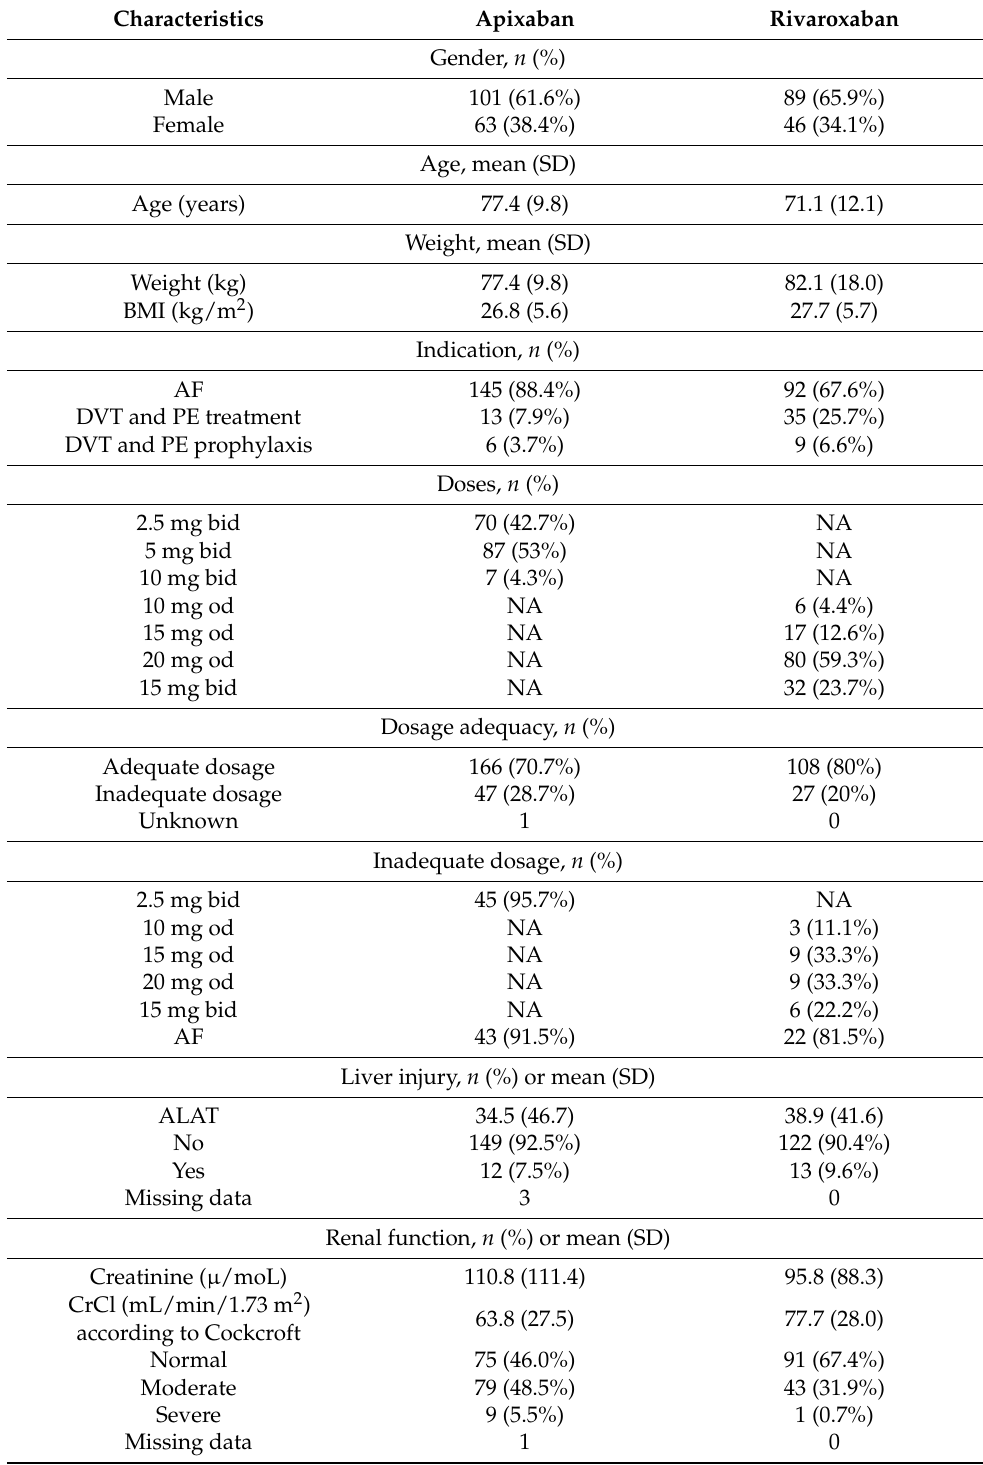
Table 1. Demographic characteristics of included patients with apixaban and rivaroxaban